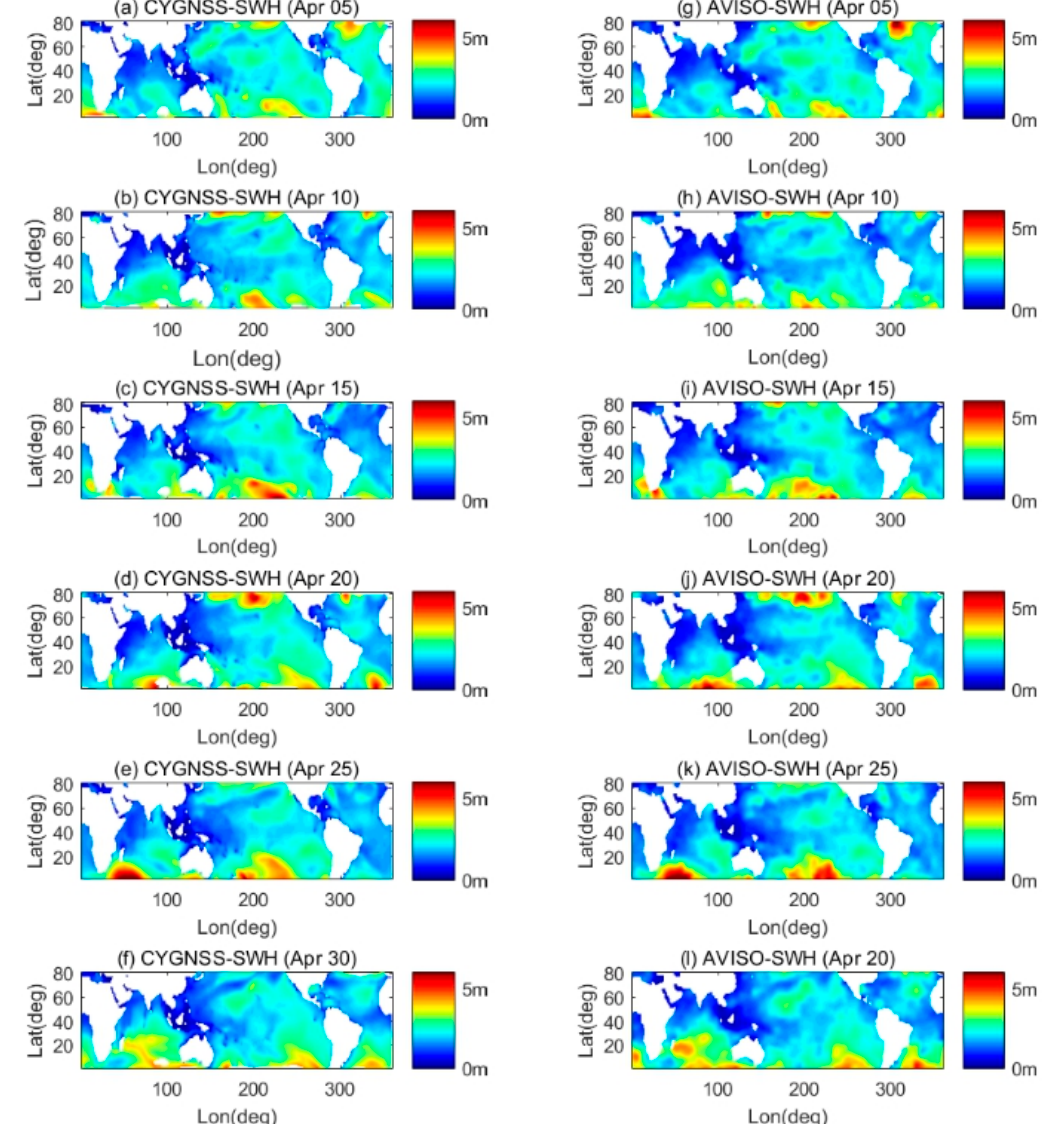
Figure 10. Comparison of CYGNSS SWH estimates (left) and AVISO satellite altimeter SWH values (right).